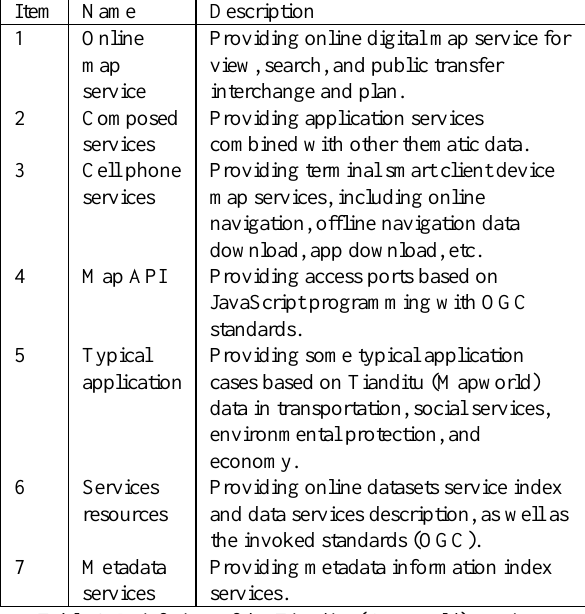
Table 2. Brief view of the Tianditu (Mapworld)